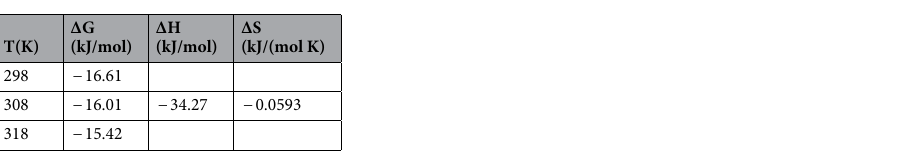
Table 5. Thermodynamic parameters for the Sb(III) sorption onto the GAD hydrogel beads.